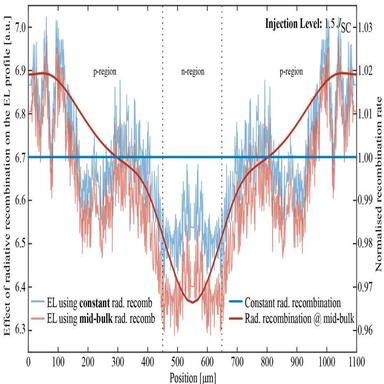
Comparison of the simulated optical outcoupling profiles for constant radiative recombination vs. radiative recombination profile at 1.5 JSC. Both profiles are for the case of optical sources placed at mid-bulk.